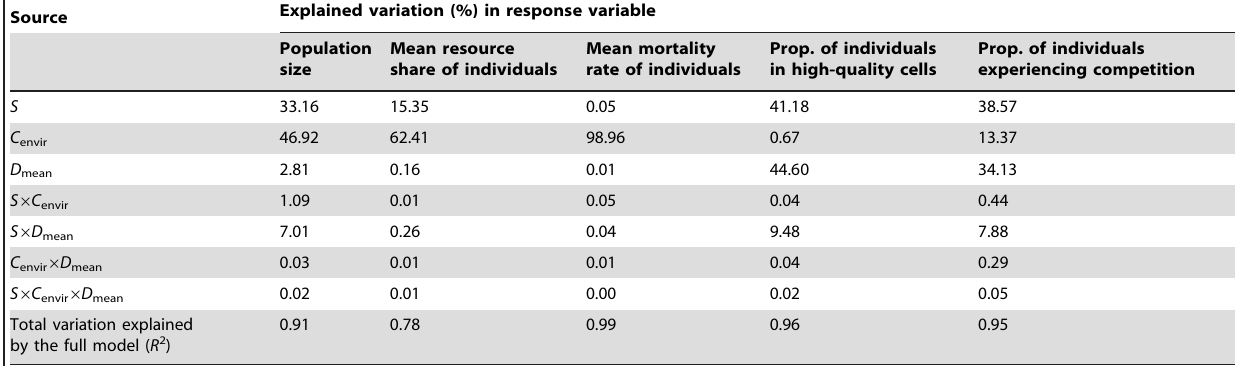
Table 2. Summary of the percentages of the variation in response variables explained by factors scale of spatial autocorrelation in habitat quality ( S ), species environmental tolerance ( C envir ), and mean moving distance ( D mean ). Detailed ANOVAs for each response variable are presented in Table